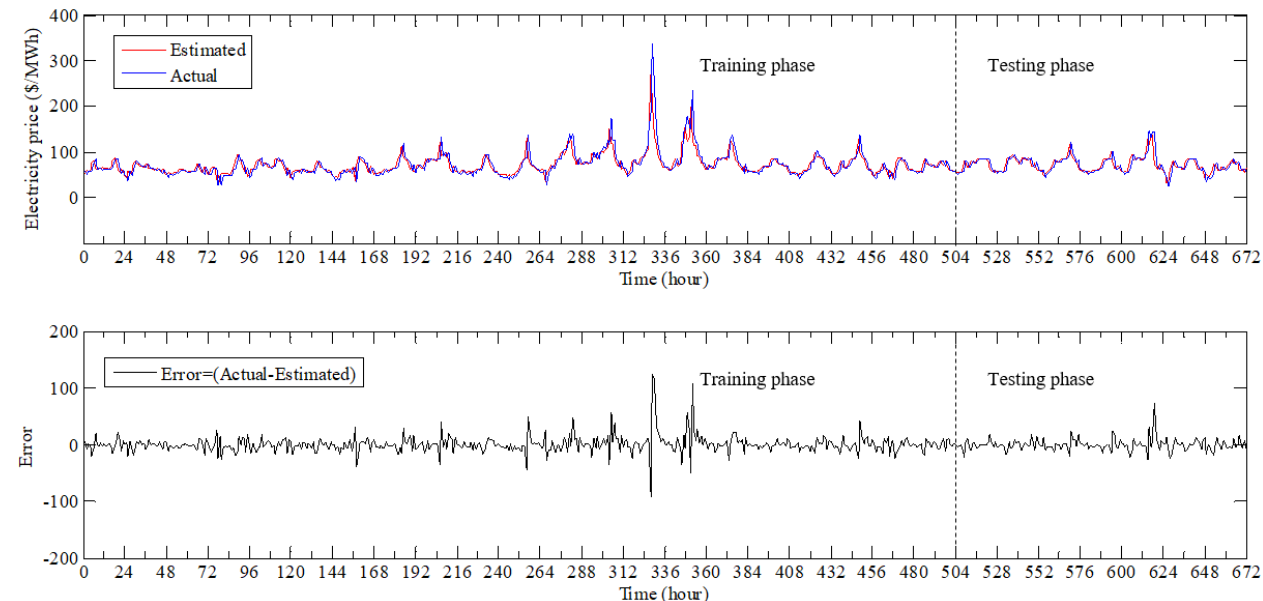
Figure 5. The evaluation of the performance throughout training at the designing and testing phases of ANFIS-BSA and its corresponding error of EPF in February 2018 for QLD.